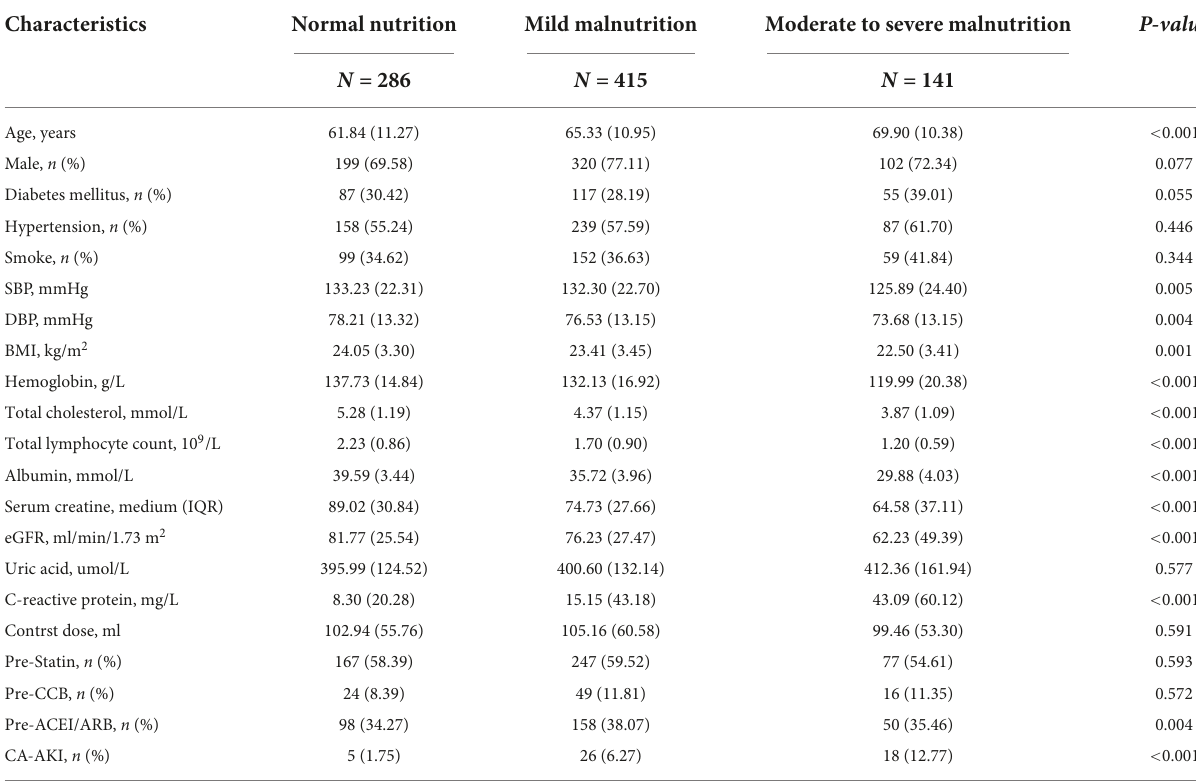
TABLE 1 Baseline characteristics in patients stratified by nutrition